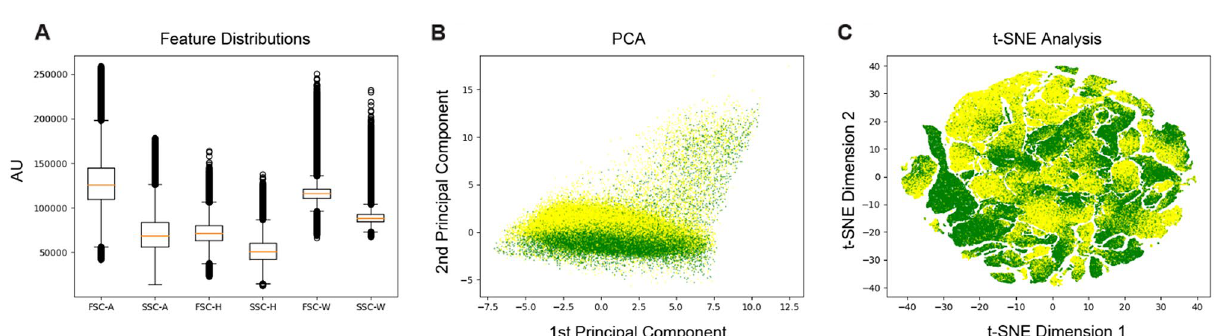
Figure 2. General statistics and visualization of the training dataset. ( A ) Box plot of the training dataset. The means of the six features (FSC-A, SSC-A, FSC-H, SSC-H, FSC-W, and SSC-W) varied significantly with the maximal ratio larger than 2.0-fold (mean FSC-A /mean SSC-H = 2.47), indicating that standardization of the original training and testing datasets are required. ( B ) Visualization of the standardized training dataset using PCA (green: FCD-WT, yellow: FCD-HT). ( C ) Visualization of the standardized training dataset using t-SNE (green: FCD-WT, yellow: